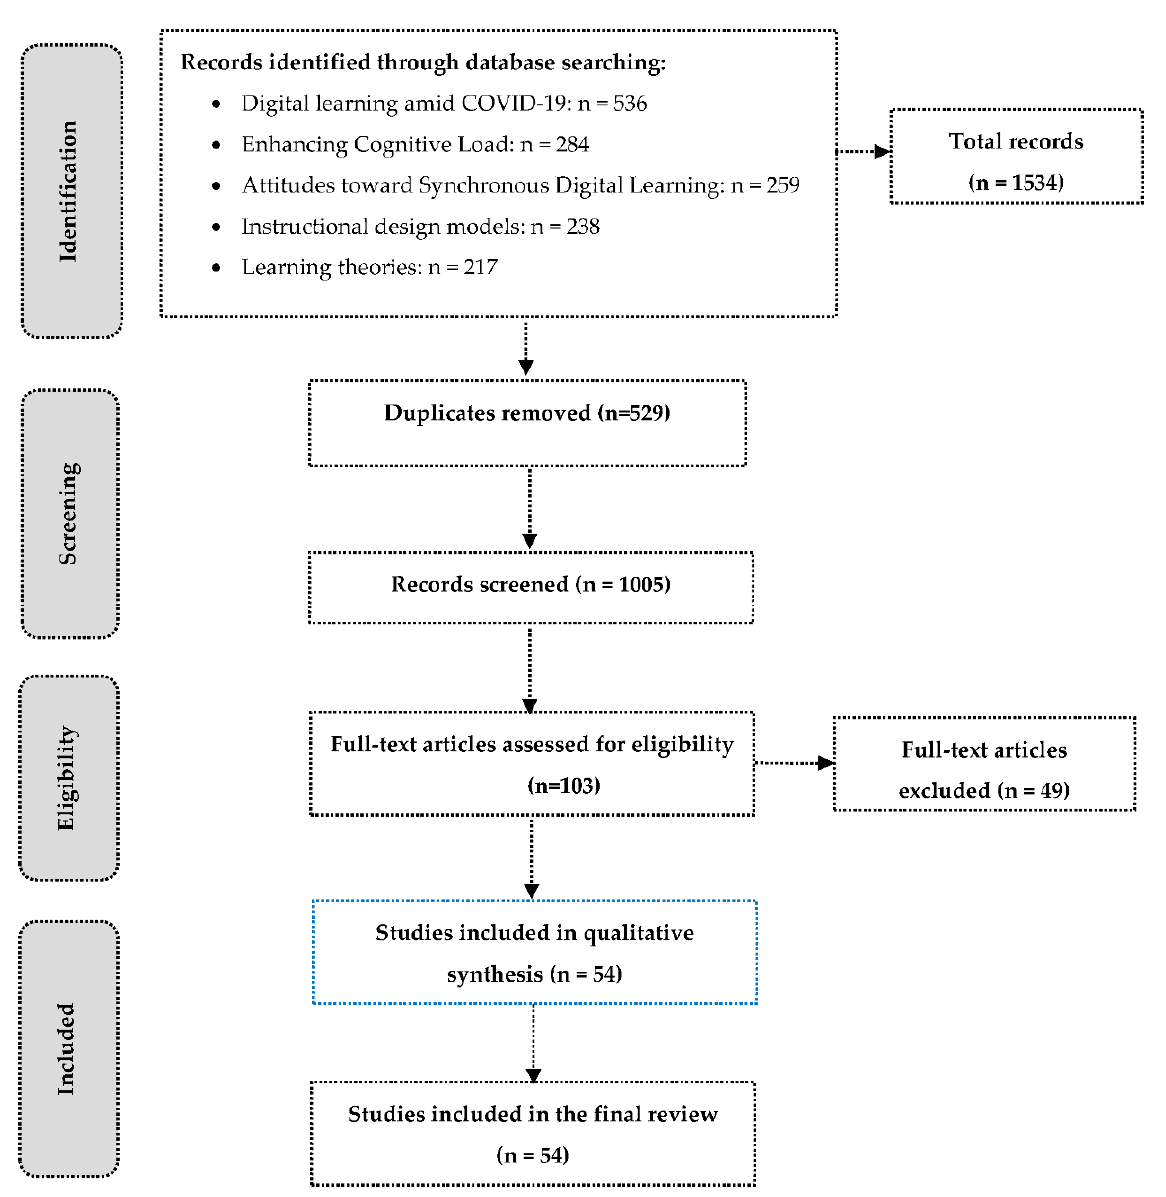
Figure A1. The process of literature review to develop the model.